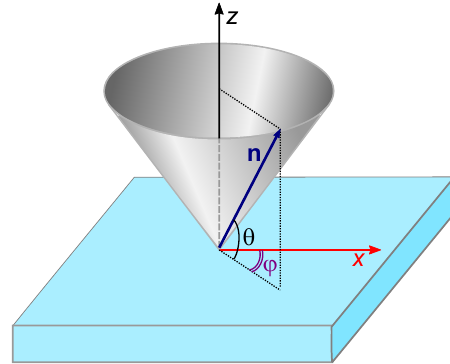
Figure 1. Scheme of conical surface anchoring of director n with the substrate. θ and ϕ are the tilt and azimuthal angles,